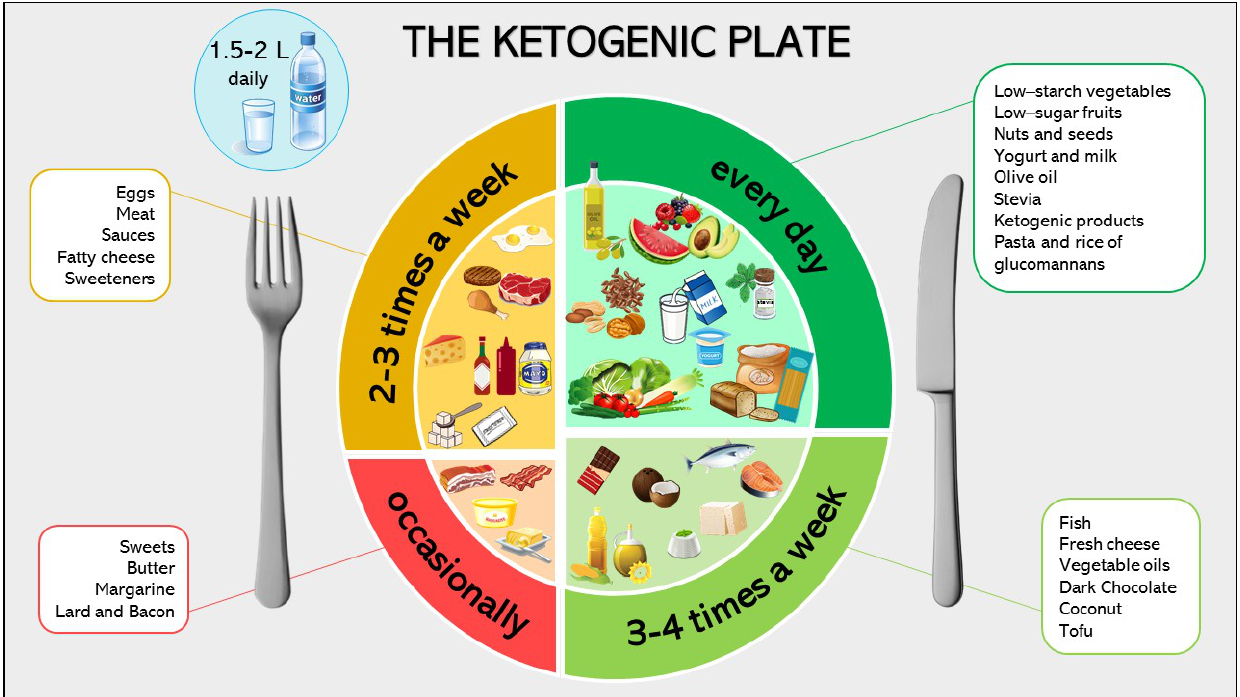
Figure 2. The ketogenic plate.